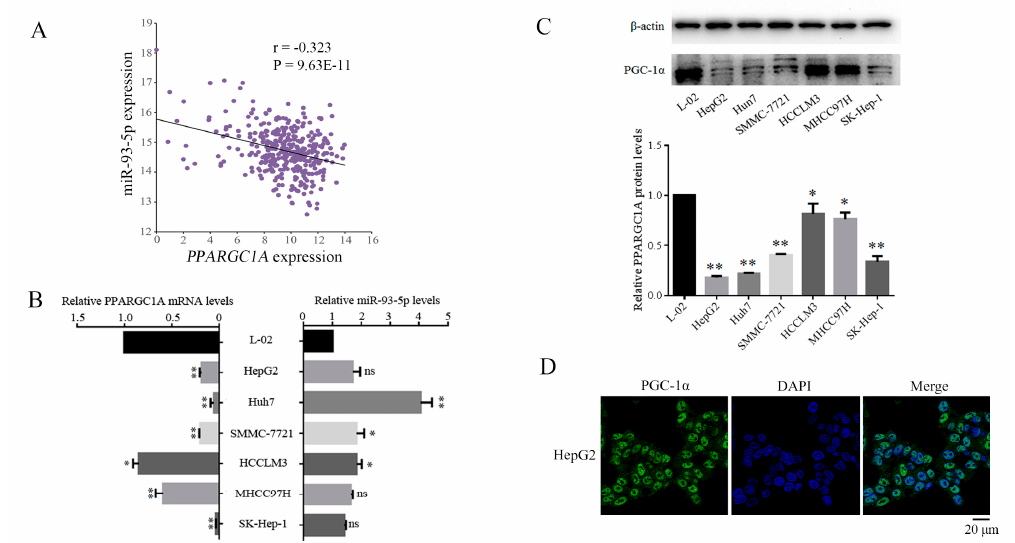
Figure 3. MiR-93-5p negatively inversely correlated with PPARGC1A expression in hepatoma cells. ( A ) A linear regression analysis was used to analyze the correlation of PPARGC1A and miR-93-5p expression in LIHC-TCGA; ( B ) The expression level of PPARGC1A mRNA and miR-93-5p were detected in hepatic cell L-02 and six hepatoma cells by qPCR; ( C ) The expression levels of PPARGC1A protein were detected in hepatic cell L-02 and six hepatoma cells by western blot; ( D ) The immunofluorescence pictures of PPARGC1A in HepG2 cell line were shown. * p < 0.05, ** p < 0.01. MiR: microRNA; qPCR: Quantitative-PCR